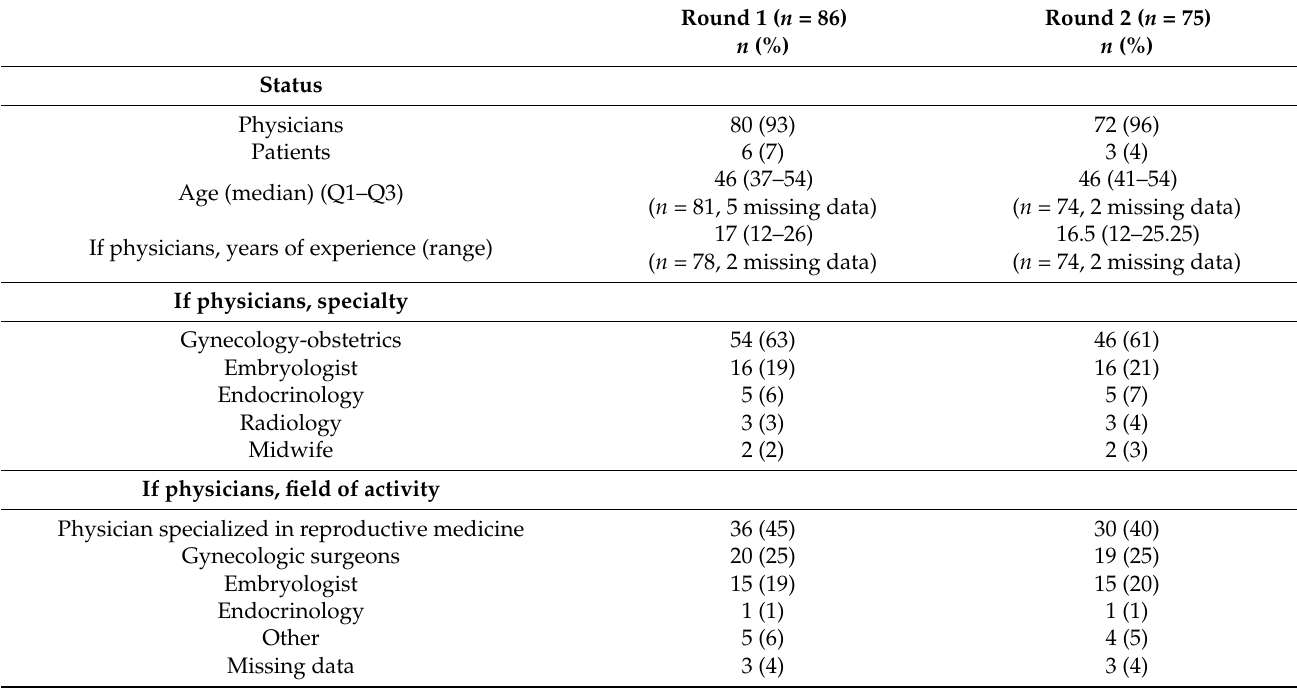
Table 1. Characteristics of the PreFerBe expert panel members who participated in the Delphi